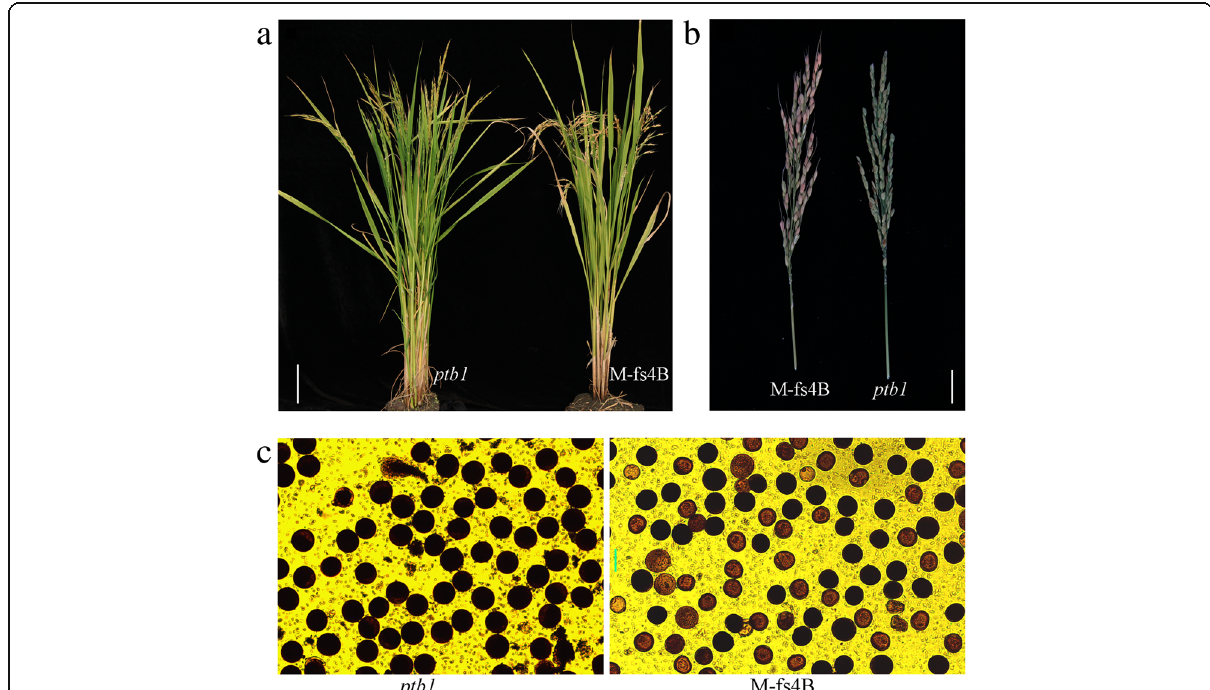
Fig. 5 Phenotype of the nuclear female sterility system. a Transgenic M-fs4B and ptb1 mutant plants. (Scale bar, 12.5 cm) ( b ) M-fs4B and ptb1 panicles. (Scale bar, 3.4 cm.) ( c ) I 2 -KI staining of M-fs4B and ptb1 pollen grains. (Scale bar, 40 μ